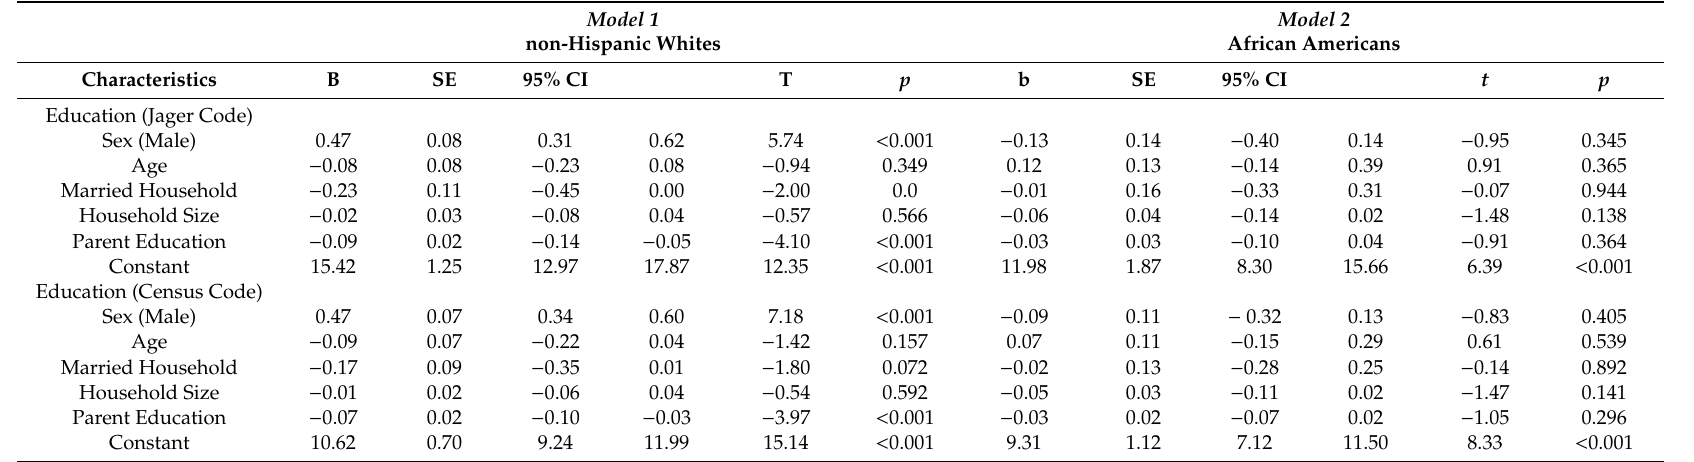
Table 3. Summary of linear regressions between parental education and reward responsiveness (RR) by race ( n =